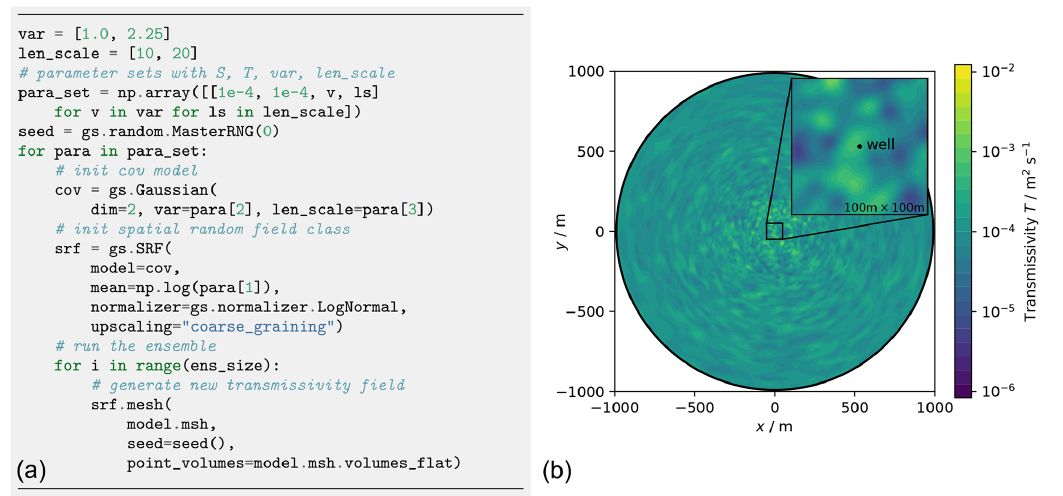
Figure 25. Workflow to generate an ensemble of transmissivity fields on a given mesh (a) . A single realization in shown in the right plot (b) .